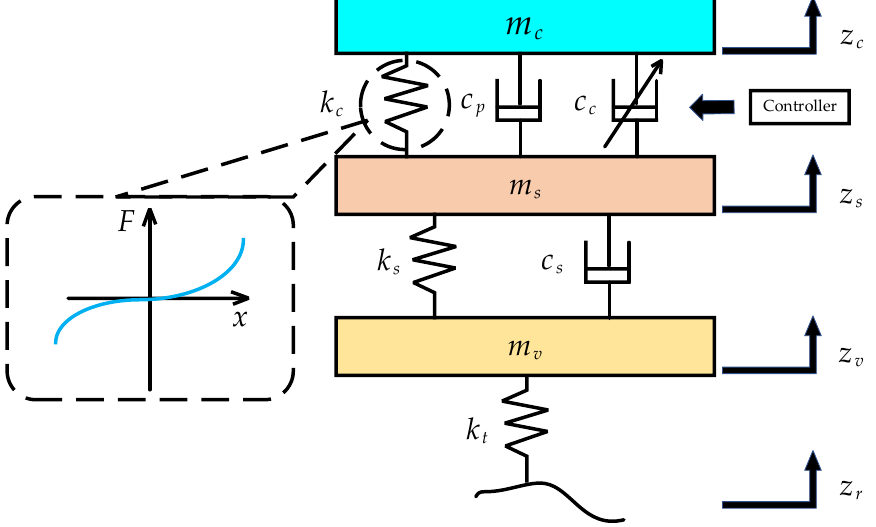
Figure 2. Quarter-cab car suspension benchmark model.